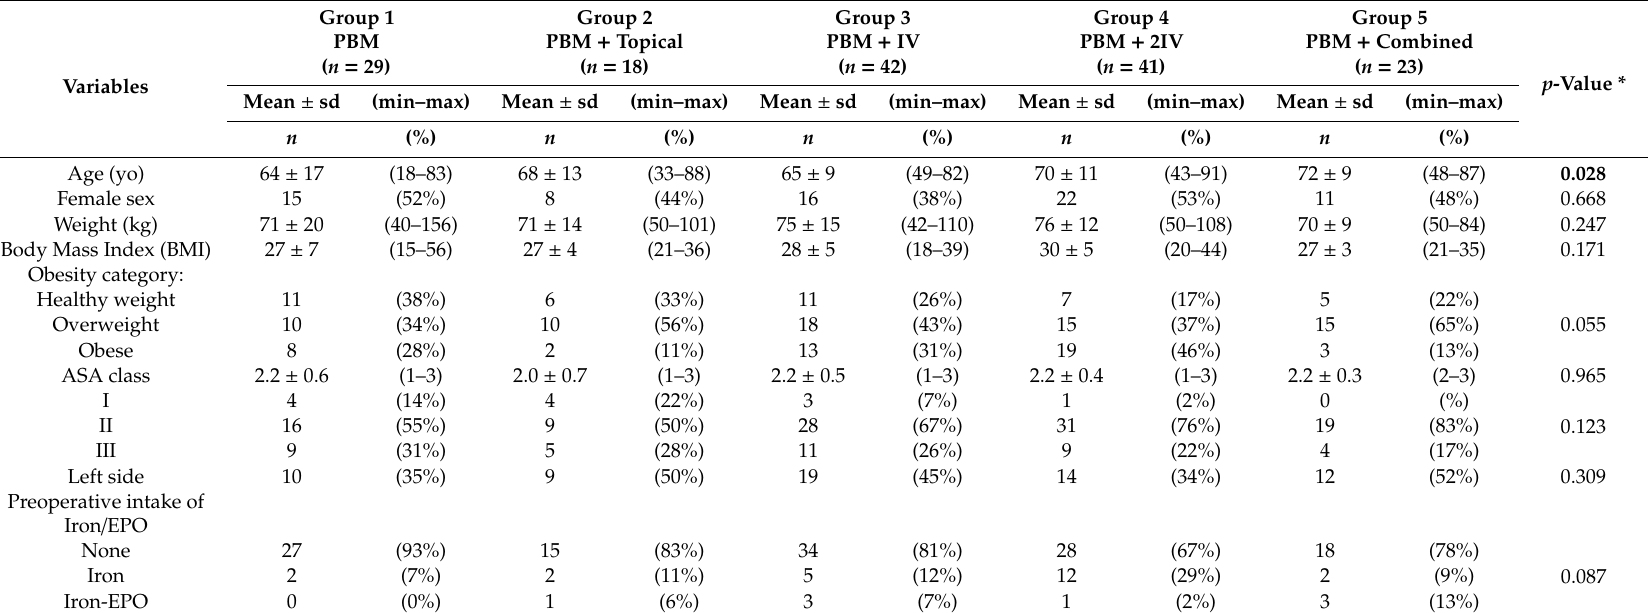
Table 1. Demographics and general characteristics of patients by group of